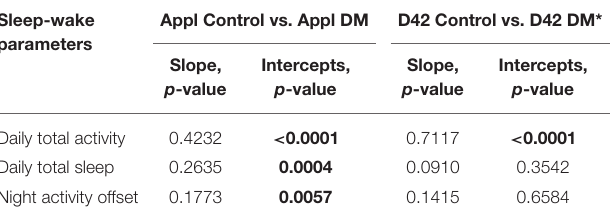
TABLE 4 | Statistical analysis of sleep-wake behavior parameters scaled to percent of life span, relied on comparison of regression curve slopes and